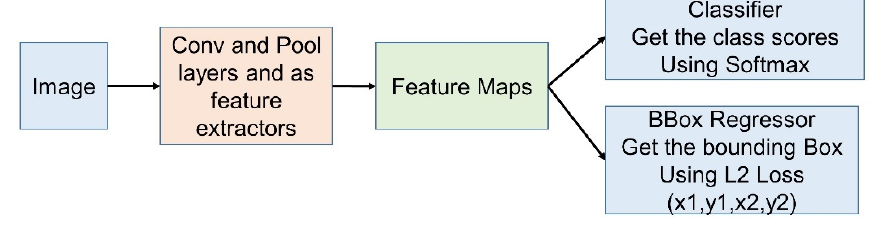
Figure 3. Detection pipeline using CNN.